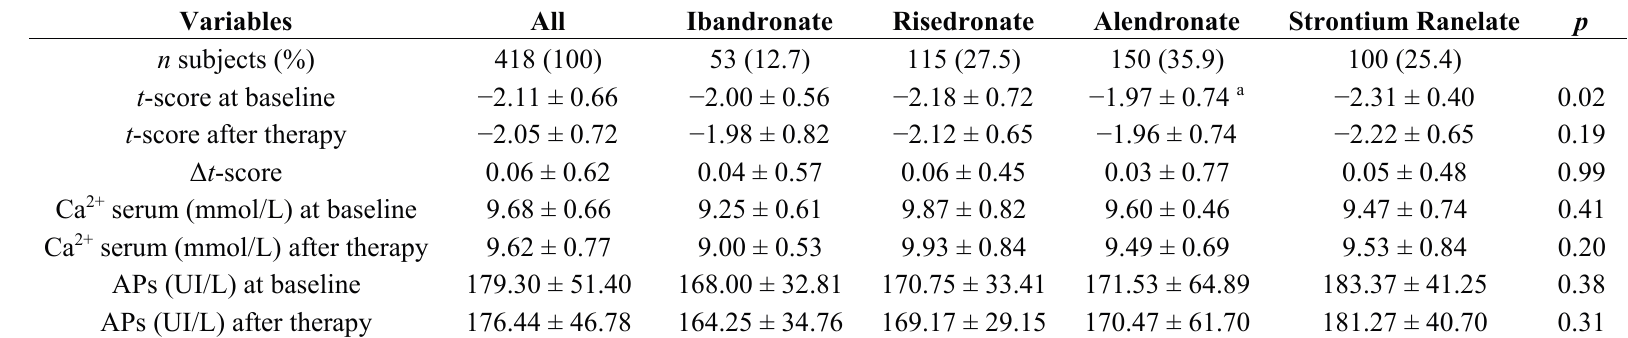
Table 3. Therapy response.